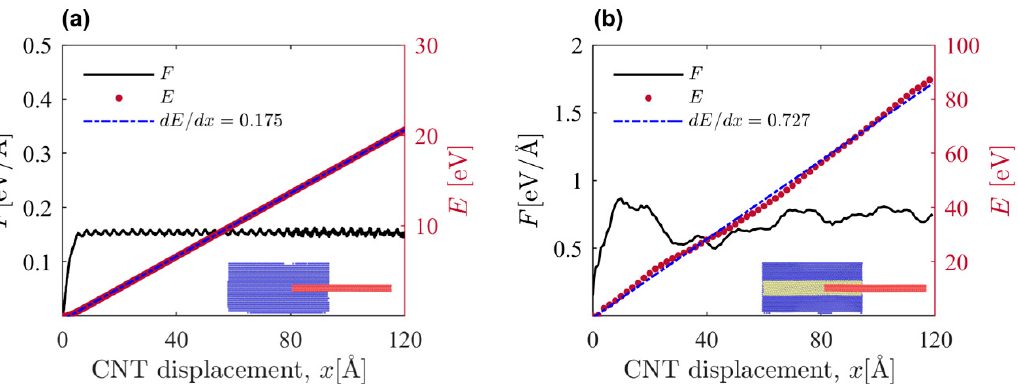
Figure 7. MD simulation of CNT pull-out from Mg matrix; ( a ) pristine CNT in Mg matrix, ( b ) Pt- coated in Mg matrix; inset pictures show the cross section of the configuration during the pull-out simulation. Blue, red, and yellow atoms at the insets represent Mg, C, and Pt atoms, respectively.